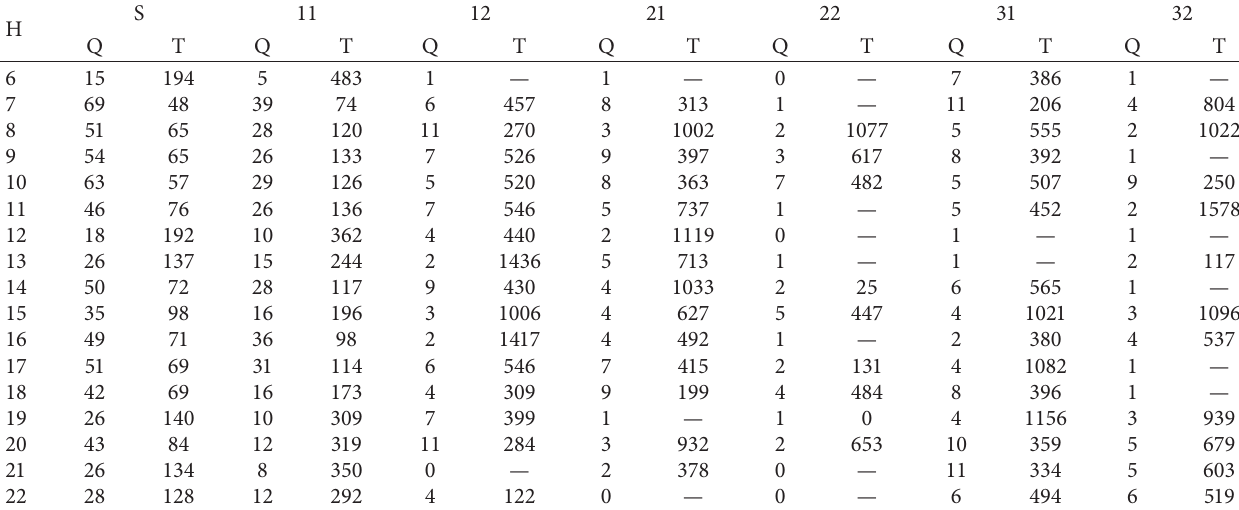
Table 1: Vehicle volume and average time headway from upstream on December 2,